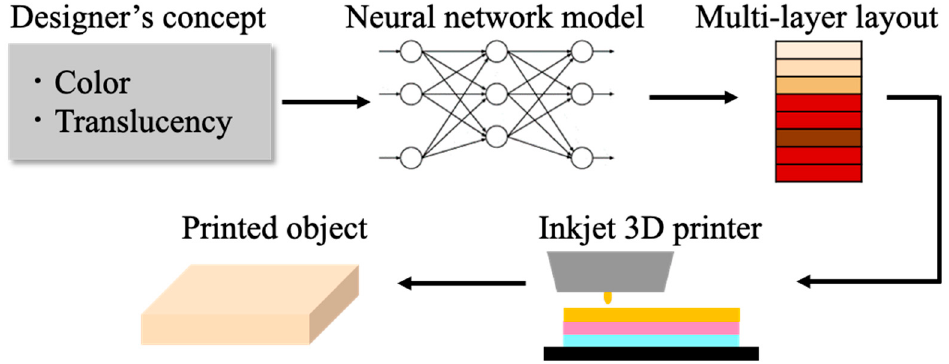
Figure 2. Overview of the method of Nagasawa et al.